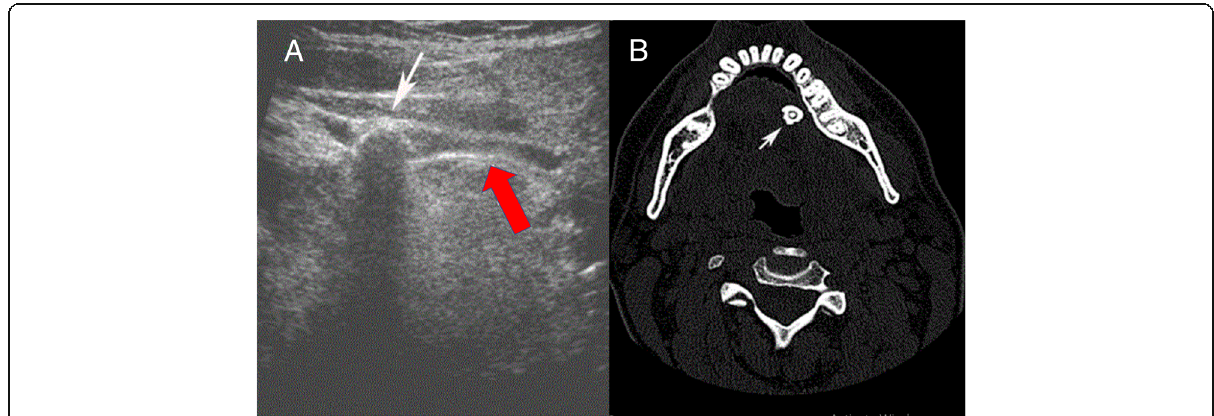
Fig. 2 U/S and CT neck show the left submandibular gland stone. A U/S neck showing a stone in the left submandibular gland (white arrow) about 1 cm and the dilatation of the duct (red arrow). B CT scan neck axial view showing the stone in the left submandibular gland measuring about 1 cm (white arrow)